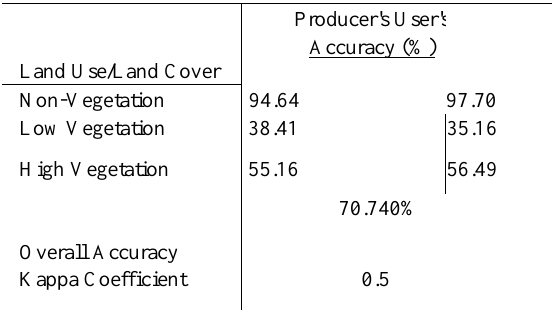
Table 2. Coefficient matrix